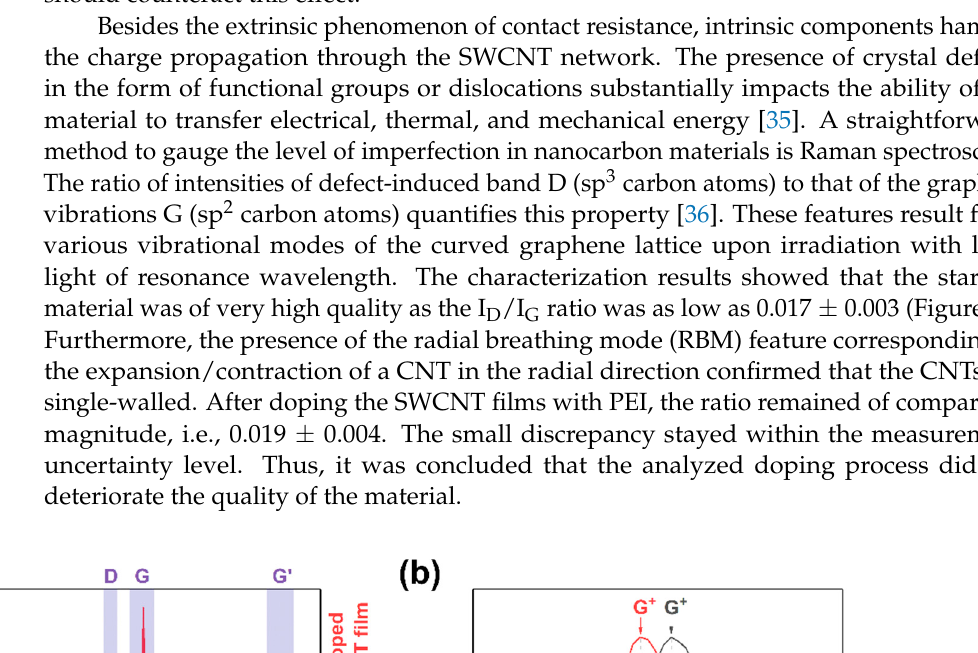
Figure 2. SEM micrographs of ( a ) neat and ( b ) PEI-doped SWCNT free-standing films. Upon doping with PEI, the microstructure of the SWCNT films stayed mostly intact.